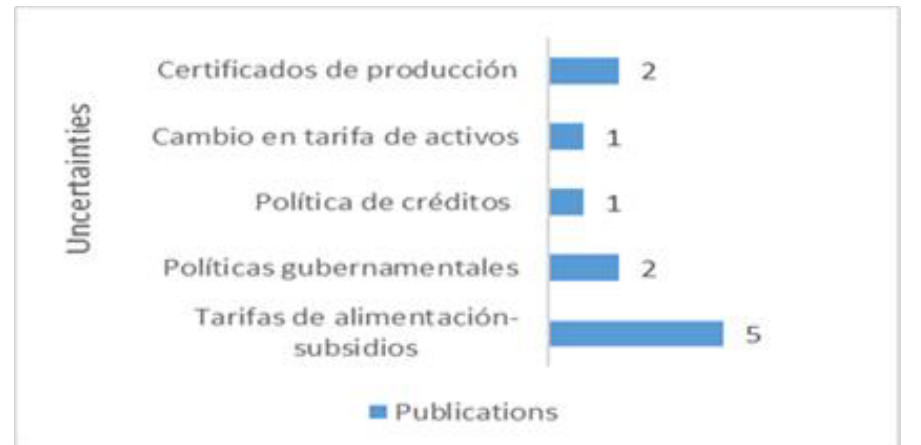
Figure 8. Regulatory policies.